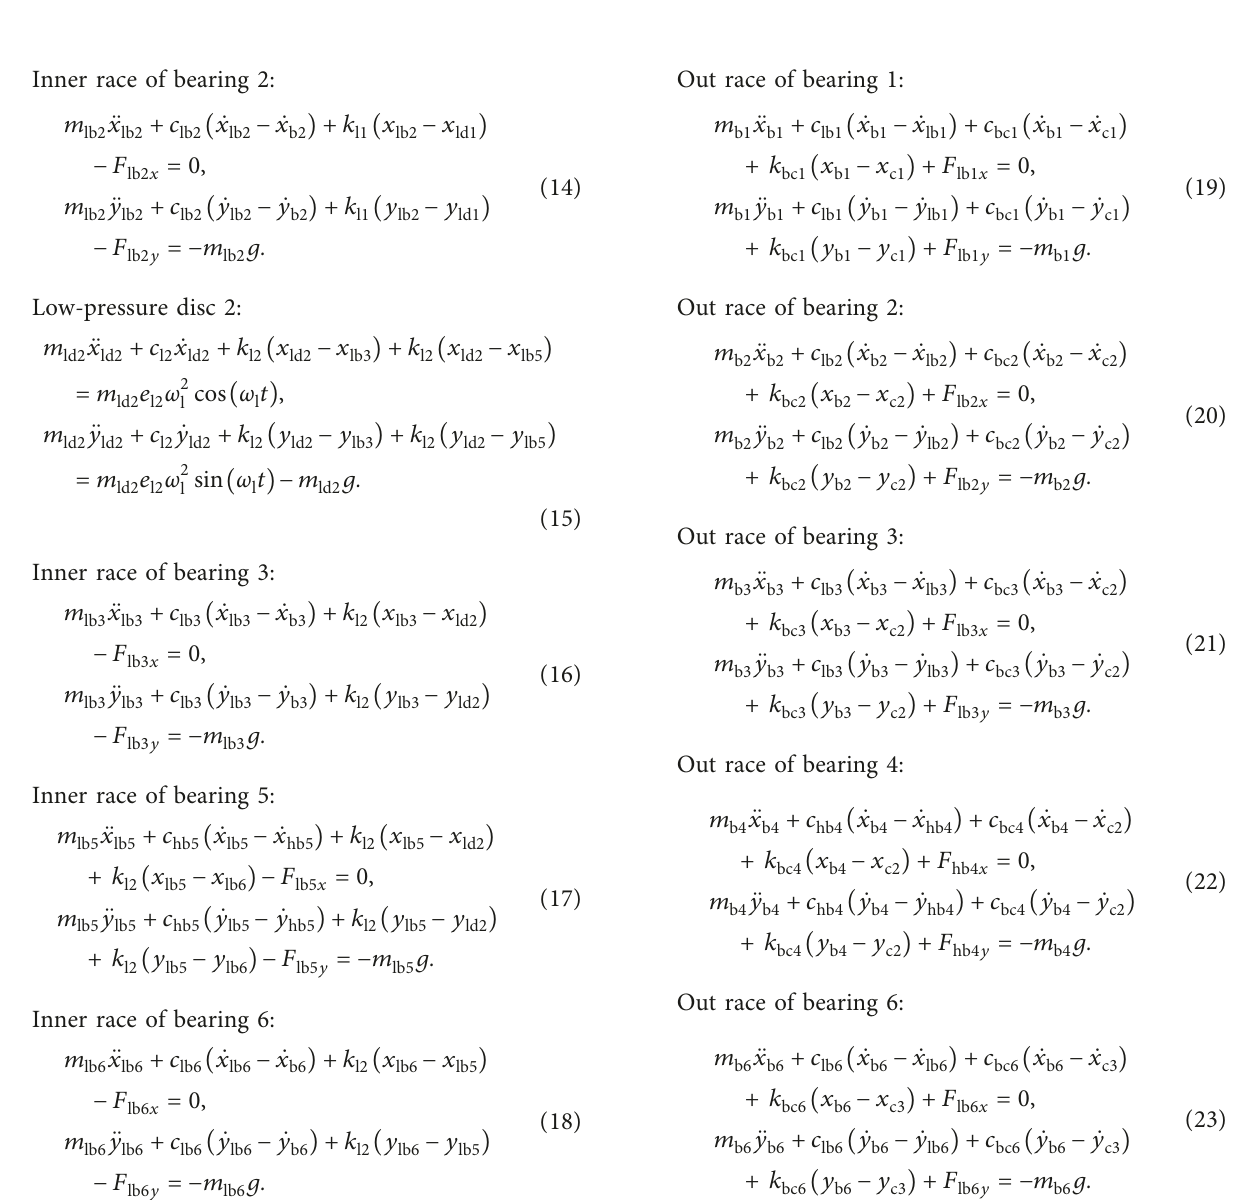
Figure 2: Dynamic model of dual-rotor-casing